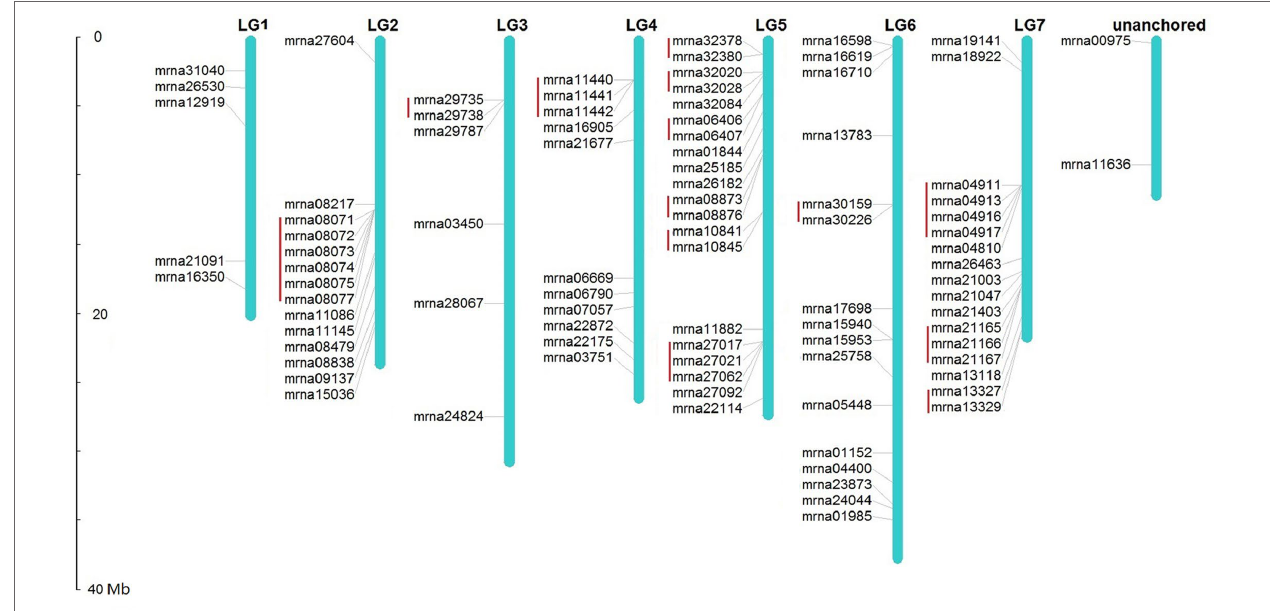
FIGURE 1 | Locations of FveERF genes on the Fragaria vesca chromosomes. The size of a chromosome is indicated by its relative length. Tandemly duplicated genes are indicated with a red